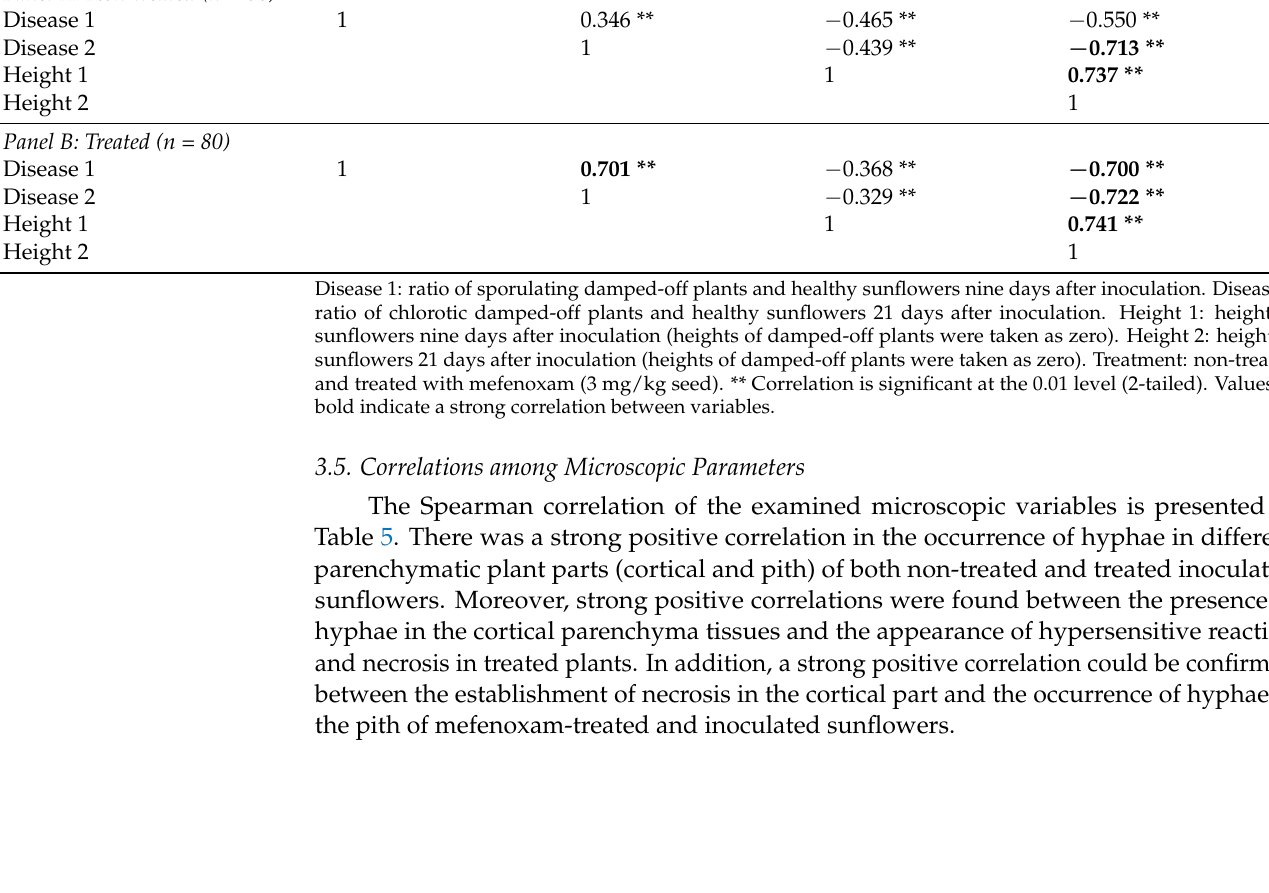
Table 4. Pearson correlation among the examined variables (disease rates, plant heights).